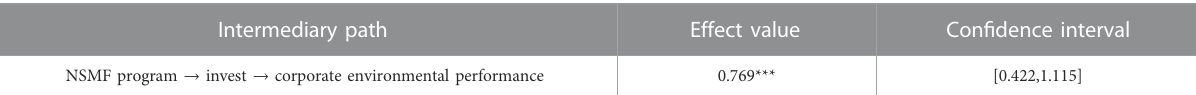
TABLE 9 Bootstrap regression